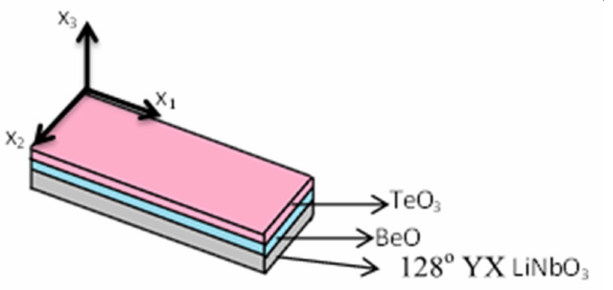
Figure 1. Illustration of TeO 3 /Beryllium Oxide (BeO)/128 ◦ YX LiNbO 3 multilayer surface acoustic wave (SAW) structure and the coordinate